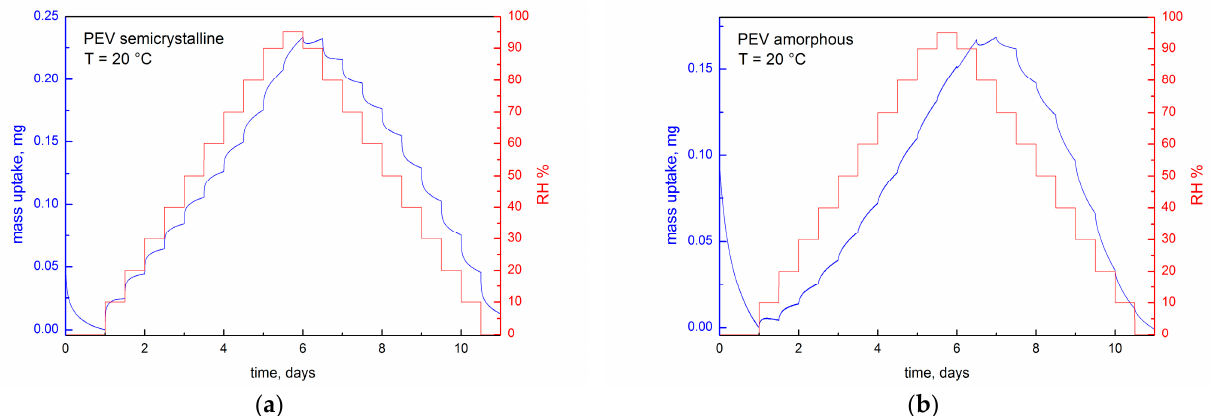
Figure 3. Example of gravimetric water vapor sorption/desorption kinetic measurements on ( a ) semicrystalline and ( b ) amorphous PEV (all measurements carried out at 20 °C).